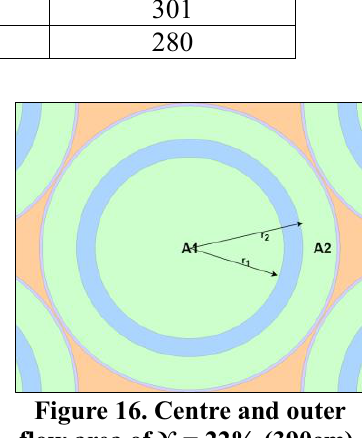
Figure 16. Centre and outer flow area of ϒ = 22%